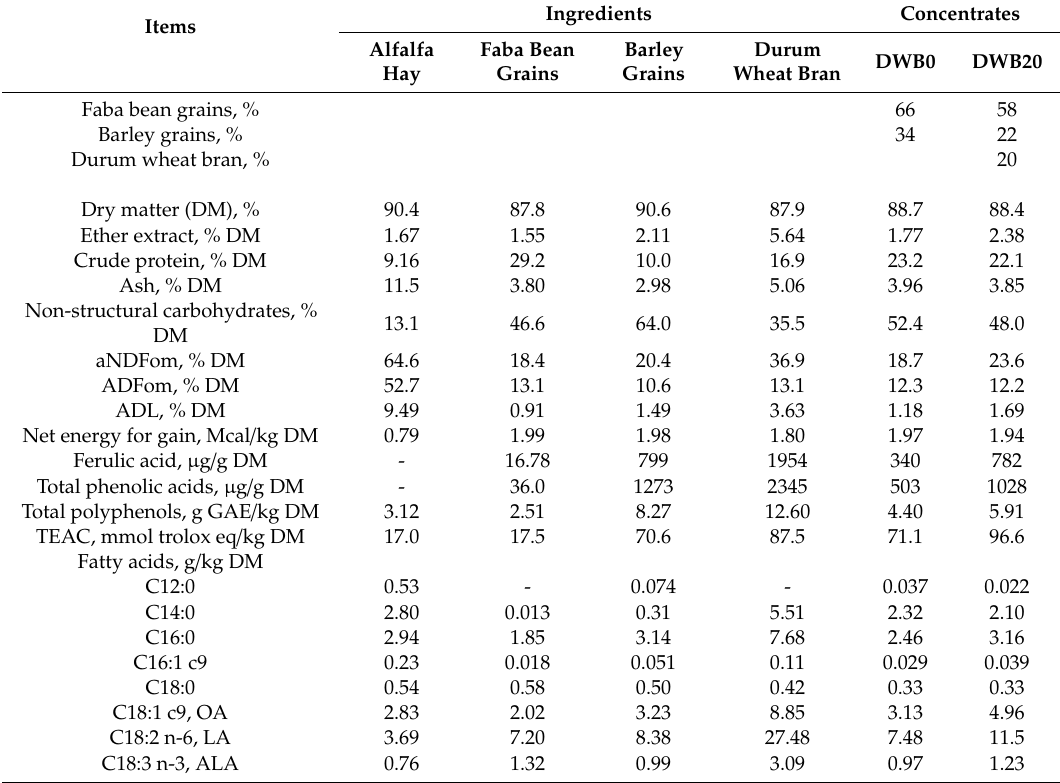
Table 1. Formulation of the concentrates, and chemical composition, antioxidant capacity and fatty acids of the diet ingredients and